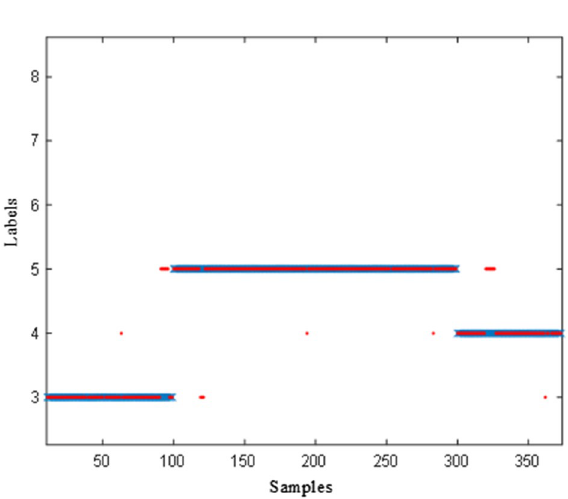
Figure 12. Classification results for the dynamic test.